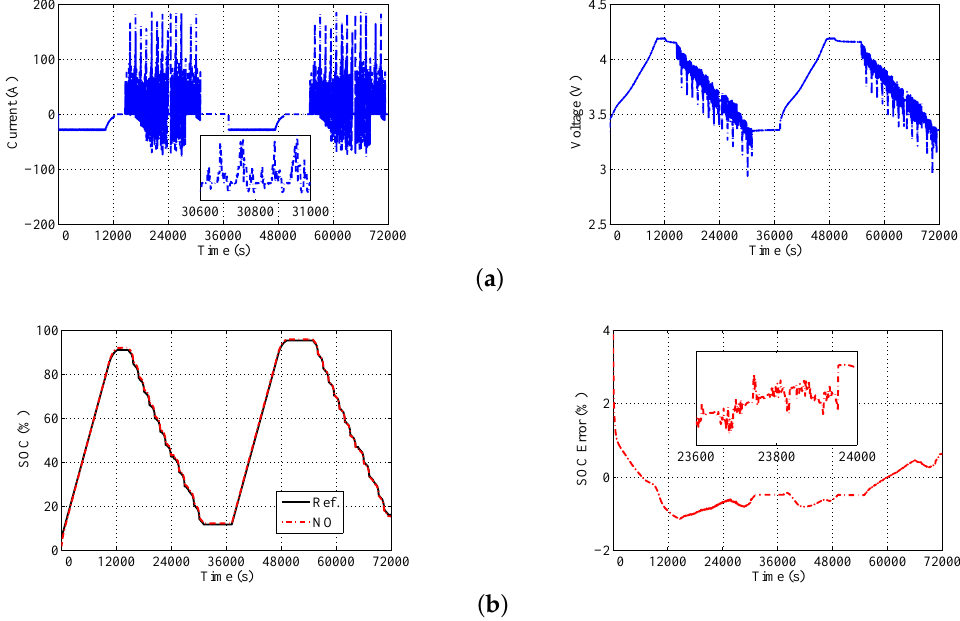
Figure 11. Validation results of datasets from a BMS in an electric EV pack: ( a ) dynamic current profile and voltage response of NEDC test collected by a BMS; and ( b ) estimation results of